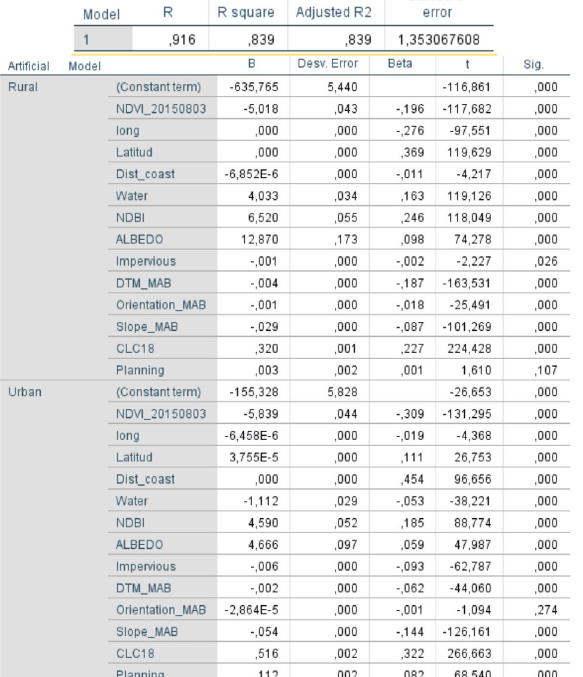
Figure 11. Nighttime LST (hybrid